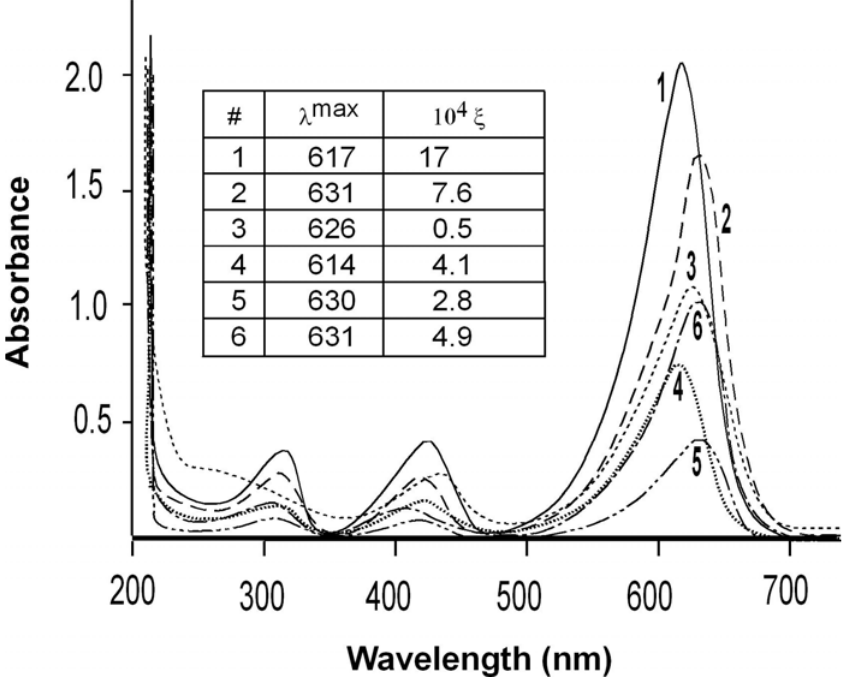
Figure 2. Visible absorption